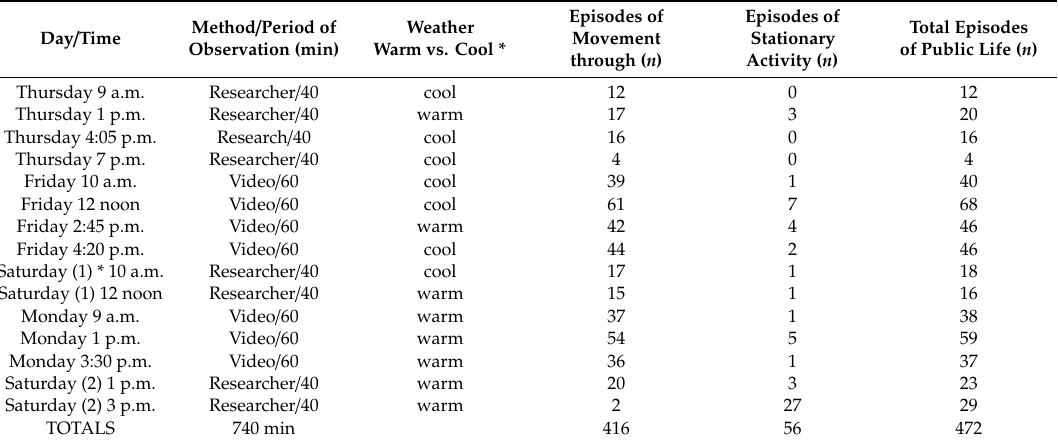
Table 2. Observational Data